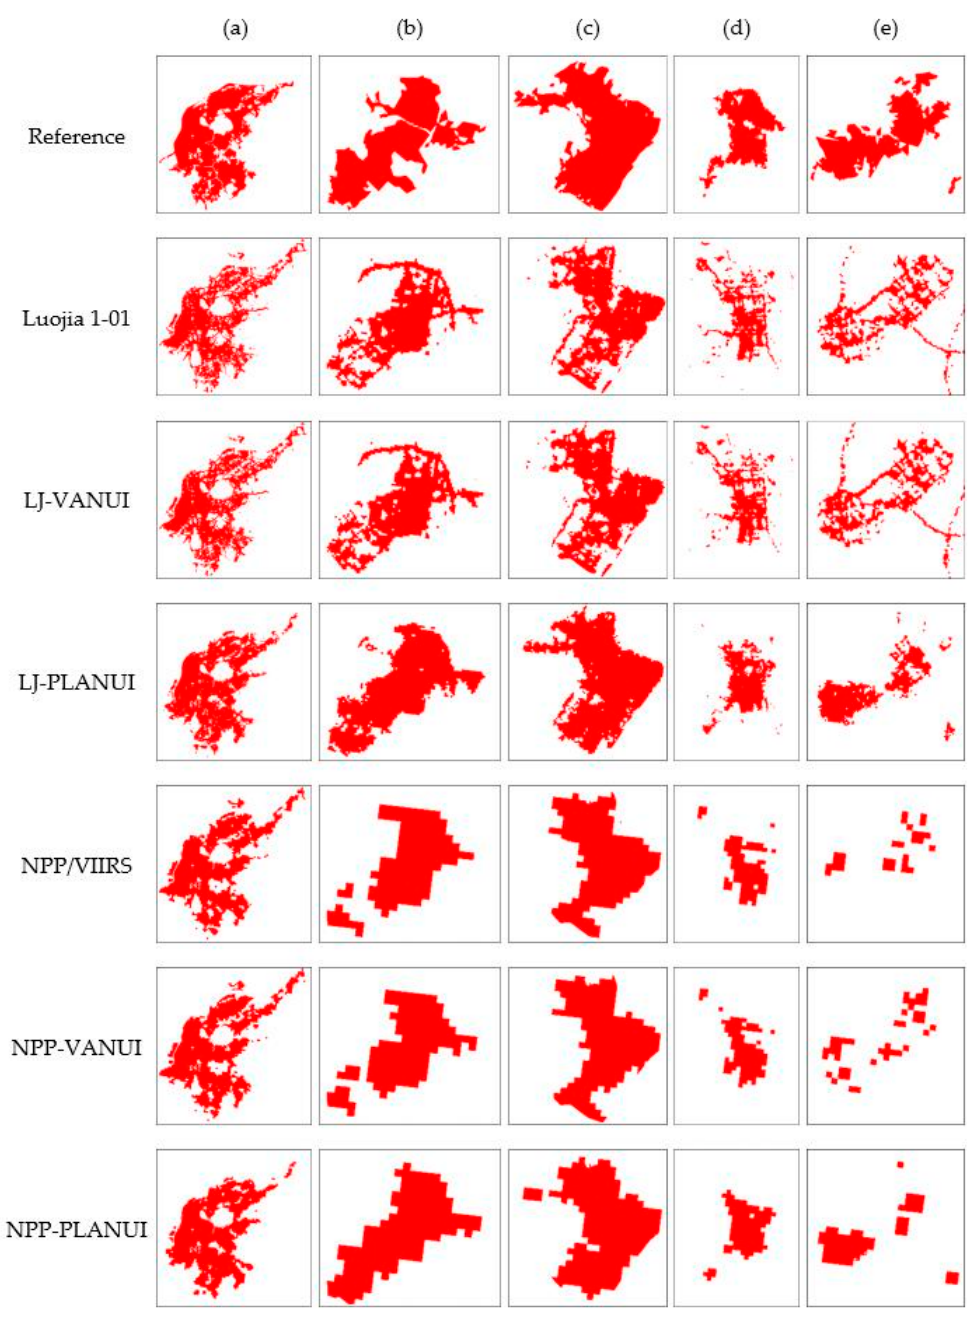
Figure 6. Comparison between reference data and extraction results from NTL, VANUI, and PLANUI in the selected regions in Nanjing: ( a ) Main Urban Area; ( b ) Liuhe; ( c ) Pukou; ( d ) Lishui; ( e )